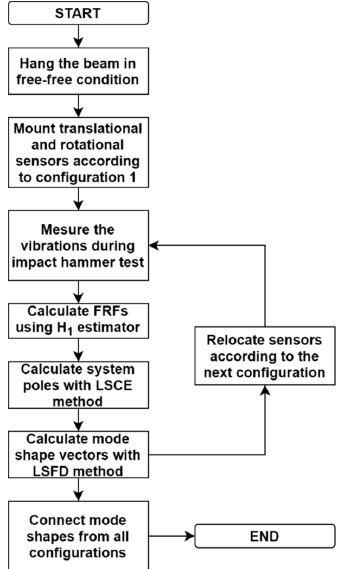
Figure 7. Flowchart of the procedure of the modal parameter extraction using an impact hammer.